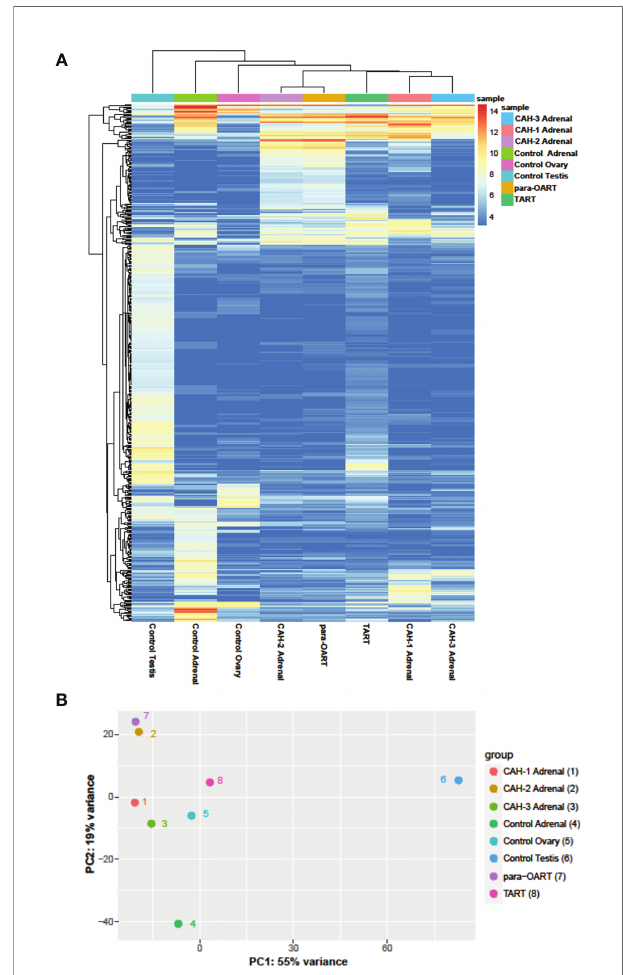
FIGURE 5 | Hierarchical clustering and principle component analysis of ART, CAH adrenals and control tissues. (A) Heatmap of unsupervised clustering of the samples showing the top 500 most- variable genes, and (B) Principal Component Analysis (PCA) showing the correlation between the